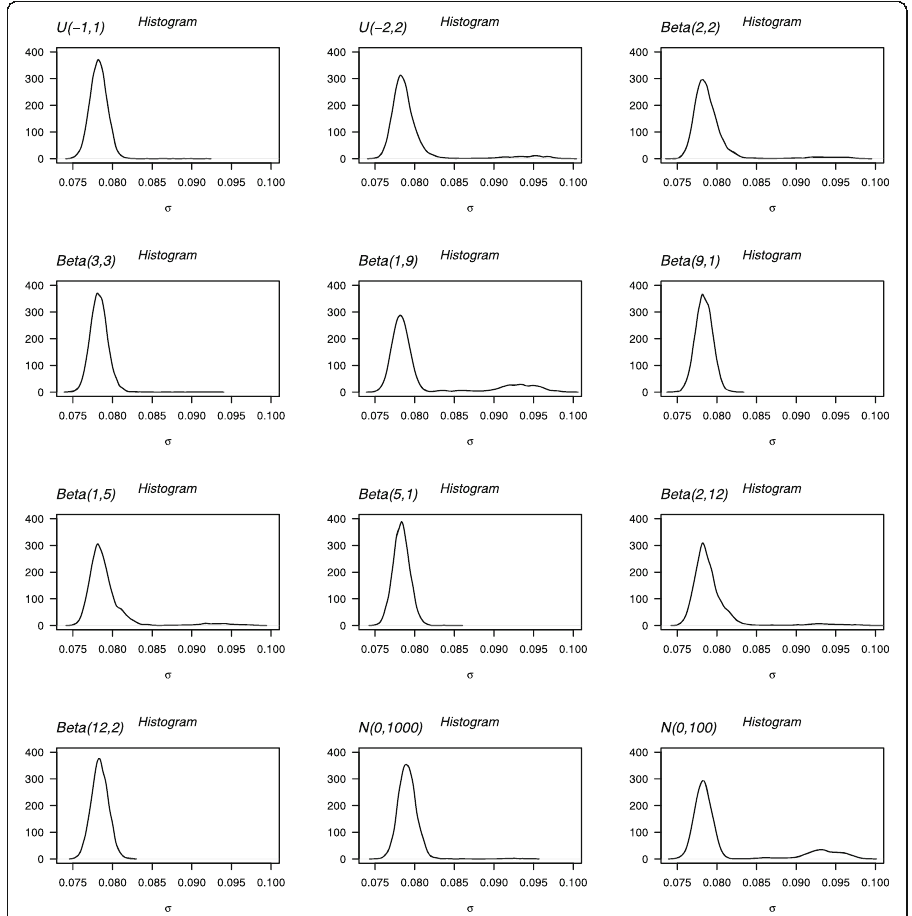
Fig. 15 Prior sensitivity analysis: Marginal posterior densities for σ in the validating forecasts for British women of our model using different prior specifications. We use the Uniform, the Beta, and the Normal distribution with different parameter values to determine various levels of their location and spread. Despite these different prior specifications, the resulting marginal posterior densities are (very)